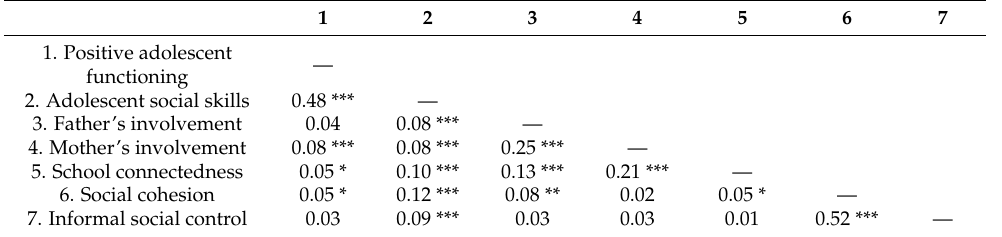
Table 2. Correlations among key study variables.